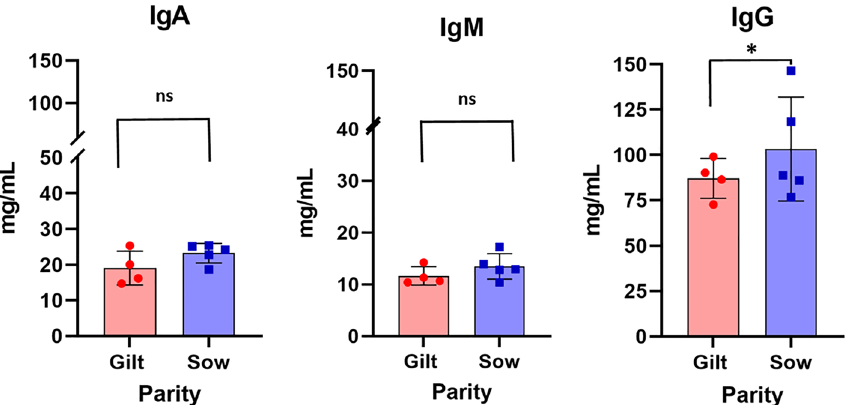
Figure 1. Comparison of total IgG, IgM, and IgA concentrations (mg/mL) in colostrum from gilts and sows in the first 3 h after farrowing. Error bars represent the standard error of the mean (± SEM). Gilt IgA (19.06 ± 1.37) vs. Sow IgA (23.25 ± 1.22), P < 0.2207; Gilt IgM (11.67 ± 0.89) vs. Sow IgM (13.49 ± 1.10), P < 0.3272; *Gilt IgG (87.09 ± 5.49) vs. Sow IgG (103.27 ± 12.8), P < 0.0112.